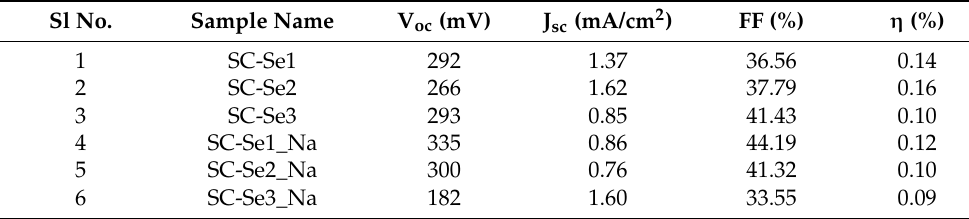
Table 3. Photovoltaic properties of CZTSe thin films with and without sodium layer. Sl No.